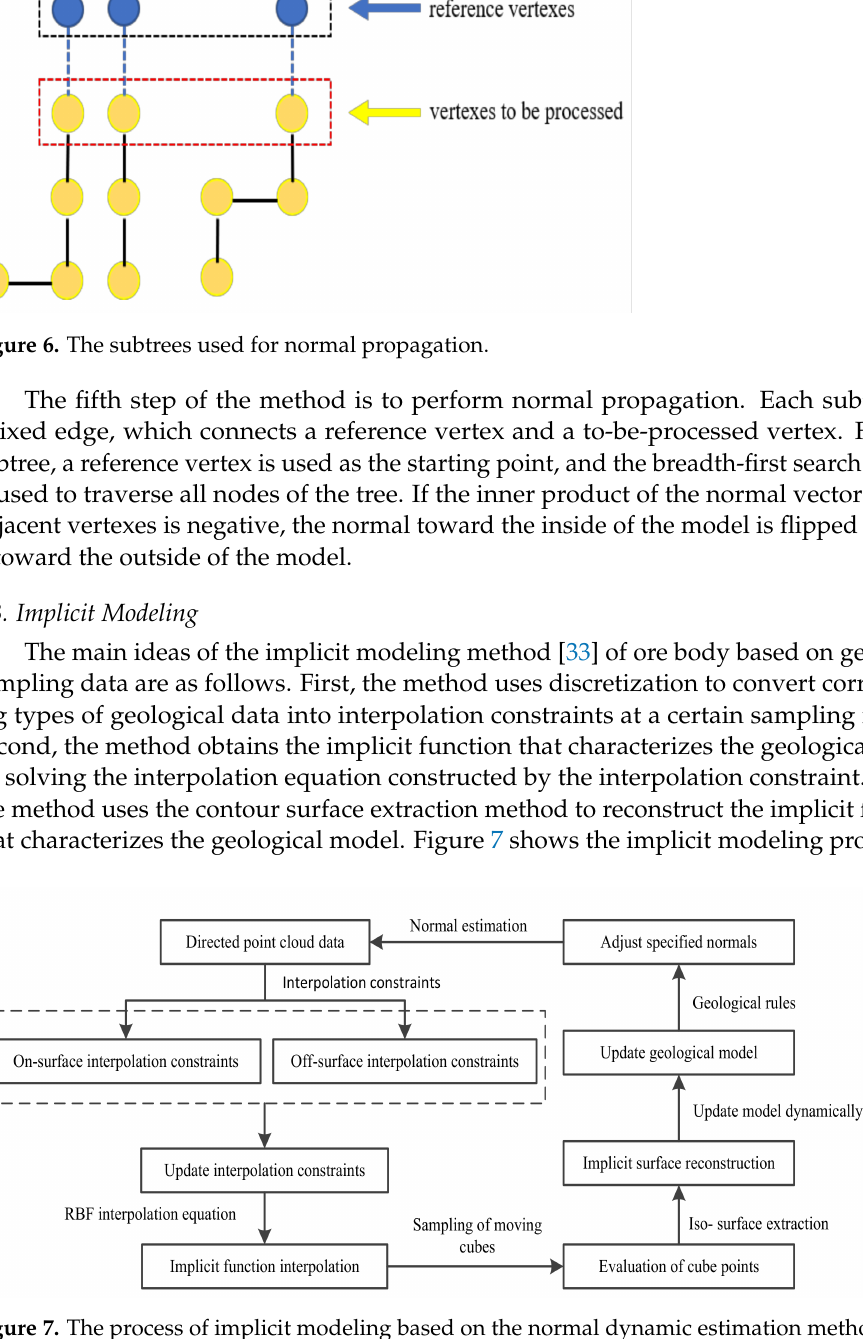
Figure 7. The process of implicit modeling based on the normal dynamic estimation